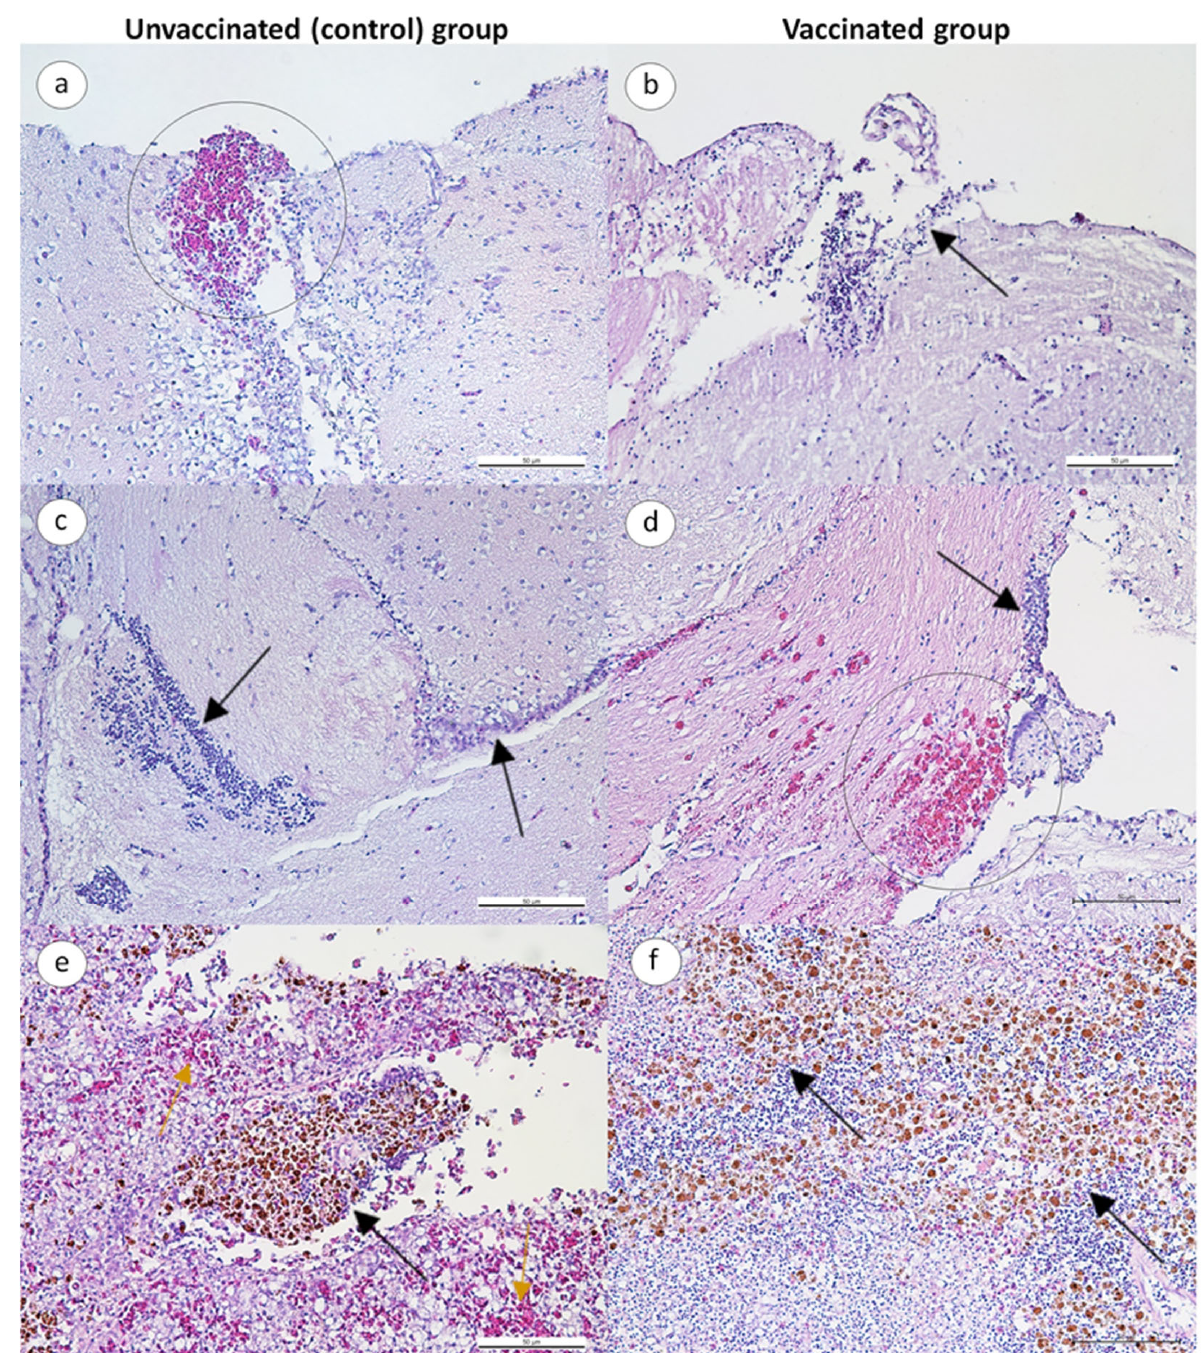
Figure 5. Photomicrograph of the brain and spleen of unvaccinated and vaccinated red hybrid tilapia following challenge with Streptococcus spp. (HE, bar = 50 µ m). ( a – c ) The brain and spleen of unvaccinated fish, and ( d – f ) the brain and spleen of vaccinated fish. ( a ) Hemorrhage and mononuclear cell infiltration (black circle). ( b ) Infiltrations of mononuclear cells in the cerebrum. ( c ) Infiltrations of mononuclear cells in the cerebrum of unvaccinated fish. ( d ) Congestion and hemorrhages (black circle), and infiltrations of mononuclear cells in the meninges (black arrow). ( e ) Melano-macrophage aggregates (black arrow) and congestion in the spleen (yellow arrow). ( f ) Melano-macrophage aggregates in the spleen (black arrow).